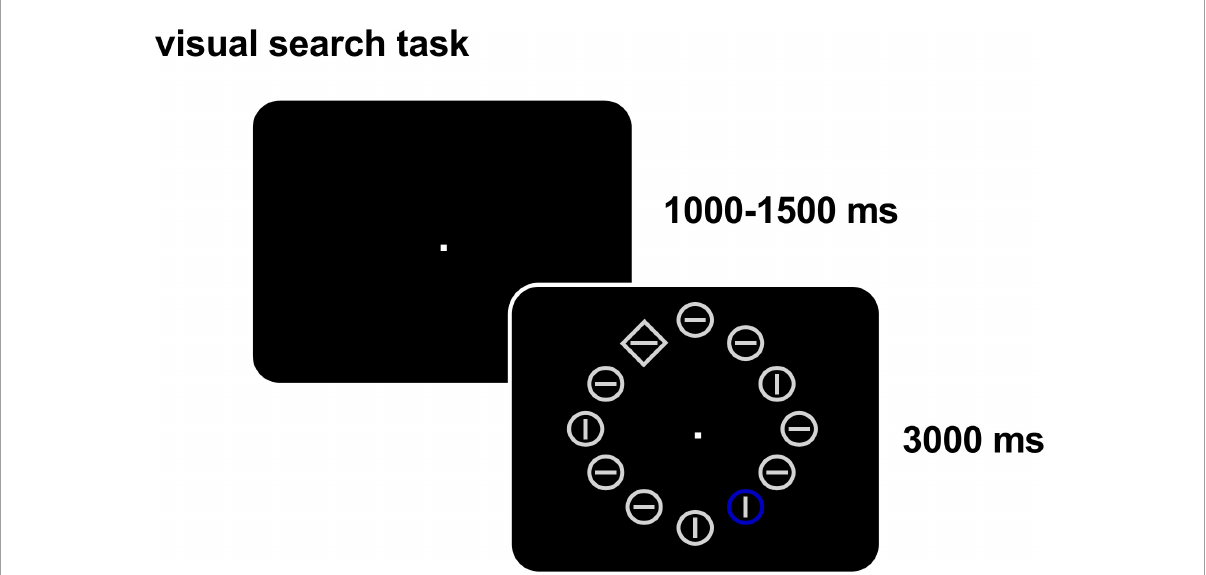
FIGURE1 Visual search task (with a distractor). In each trial, twelve items appear and participants need to determine accurately and quickly whether the straight line in the target (with different shape) is horizontal or vertical and ignore the distractor item (different color, present in 50% of the trials).